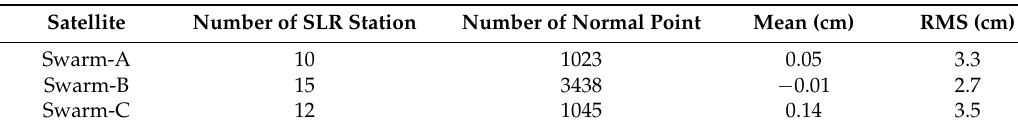
Table 4. Satellite Laser Ranging (SLR) residuals for Swarm-A/B/C.